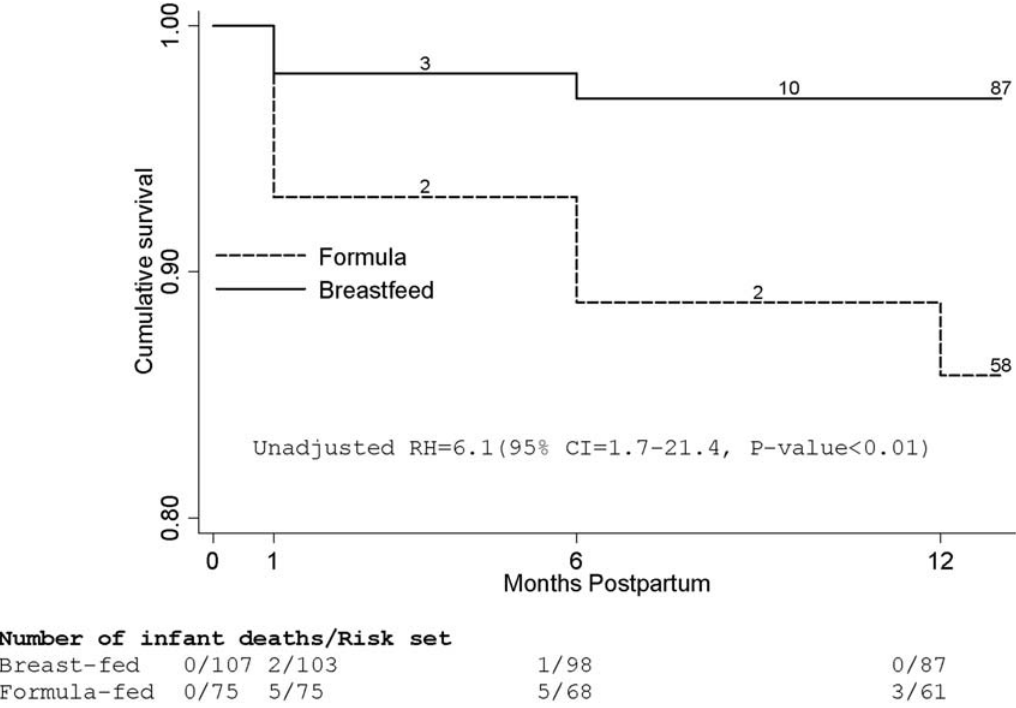
Figure 2. Kaplan-Meier cumulative probabilities of survival from death by feeding group. Actual visits grouped by the three scheduled visits at one, six and twelve months after birth.